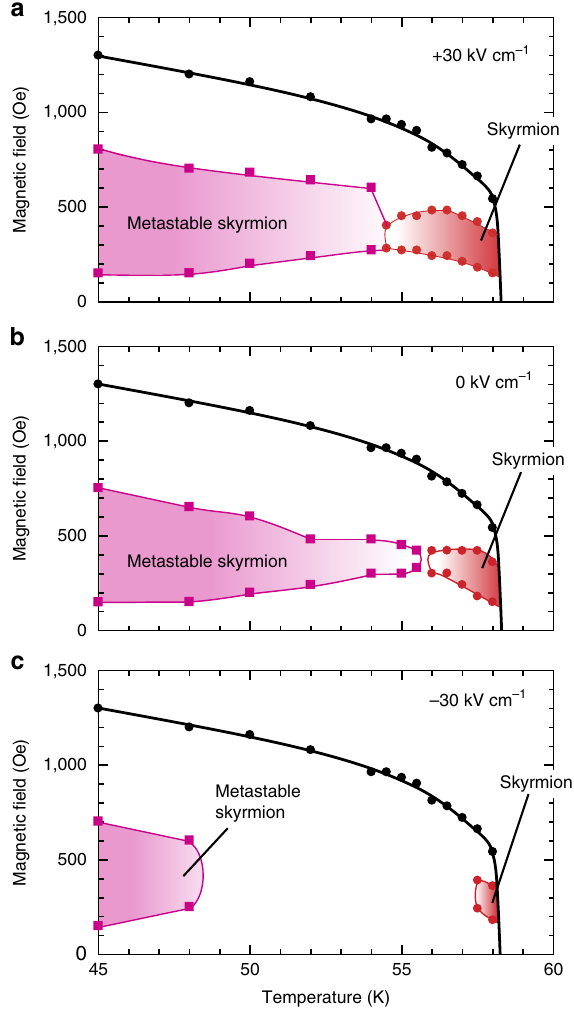
Figure 3 | Variation in the thermodynamic stability and metastability of the skyrmion phase under selected electric fields. ( a – c ), The high- temperature portion of the magnetic phase diagrams, including the metastable skyrmion states that are created by the ME cooling procedures ( E ¼ þ 30kVcm (cid:2) 1 , H ¼ 350Oe), under electric fields of þ 30 ( a ), 0 ( b ) and (cid:2) 30kVcm (cid:2) 1 ( c ). Red- and magenta-colored regions represent the thermodynamically stable and metastable skyrmion lattice states,